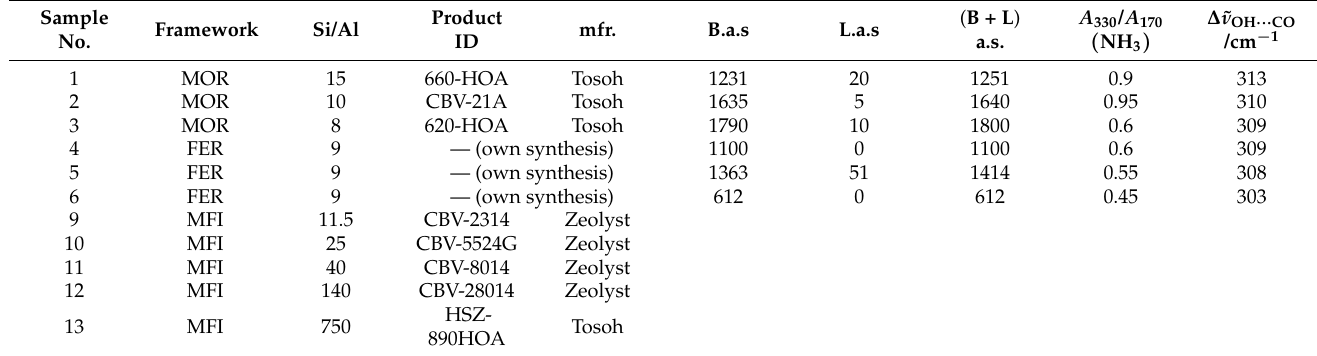
Table 1. A detailed description of the studied samples of zeolites. The value of ∆ ˜ ν OH ··· CO denotes the wavenumber shift of the OH band upon adsorption of CO. The A 330 / A 170 entity is the ratio of absorbance measured at 330 ◦ C with respect to the absorbance at 170 ◦ C. The B.a.s (L.a.s) denotes the Brønsted (Lewis) acidic sites concentration in µmol/g.